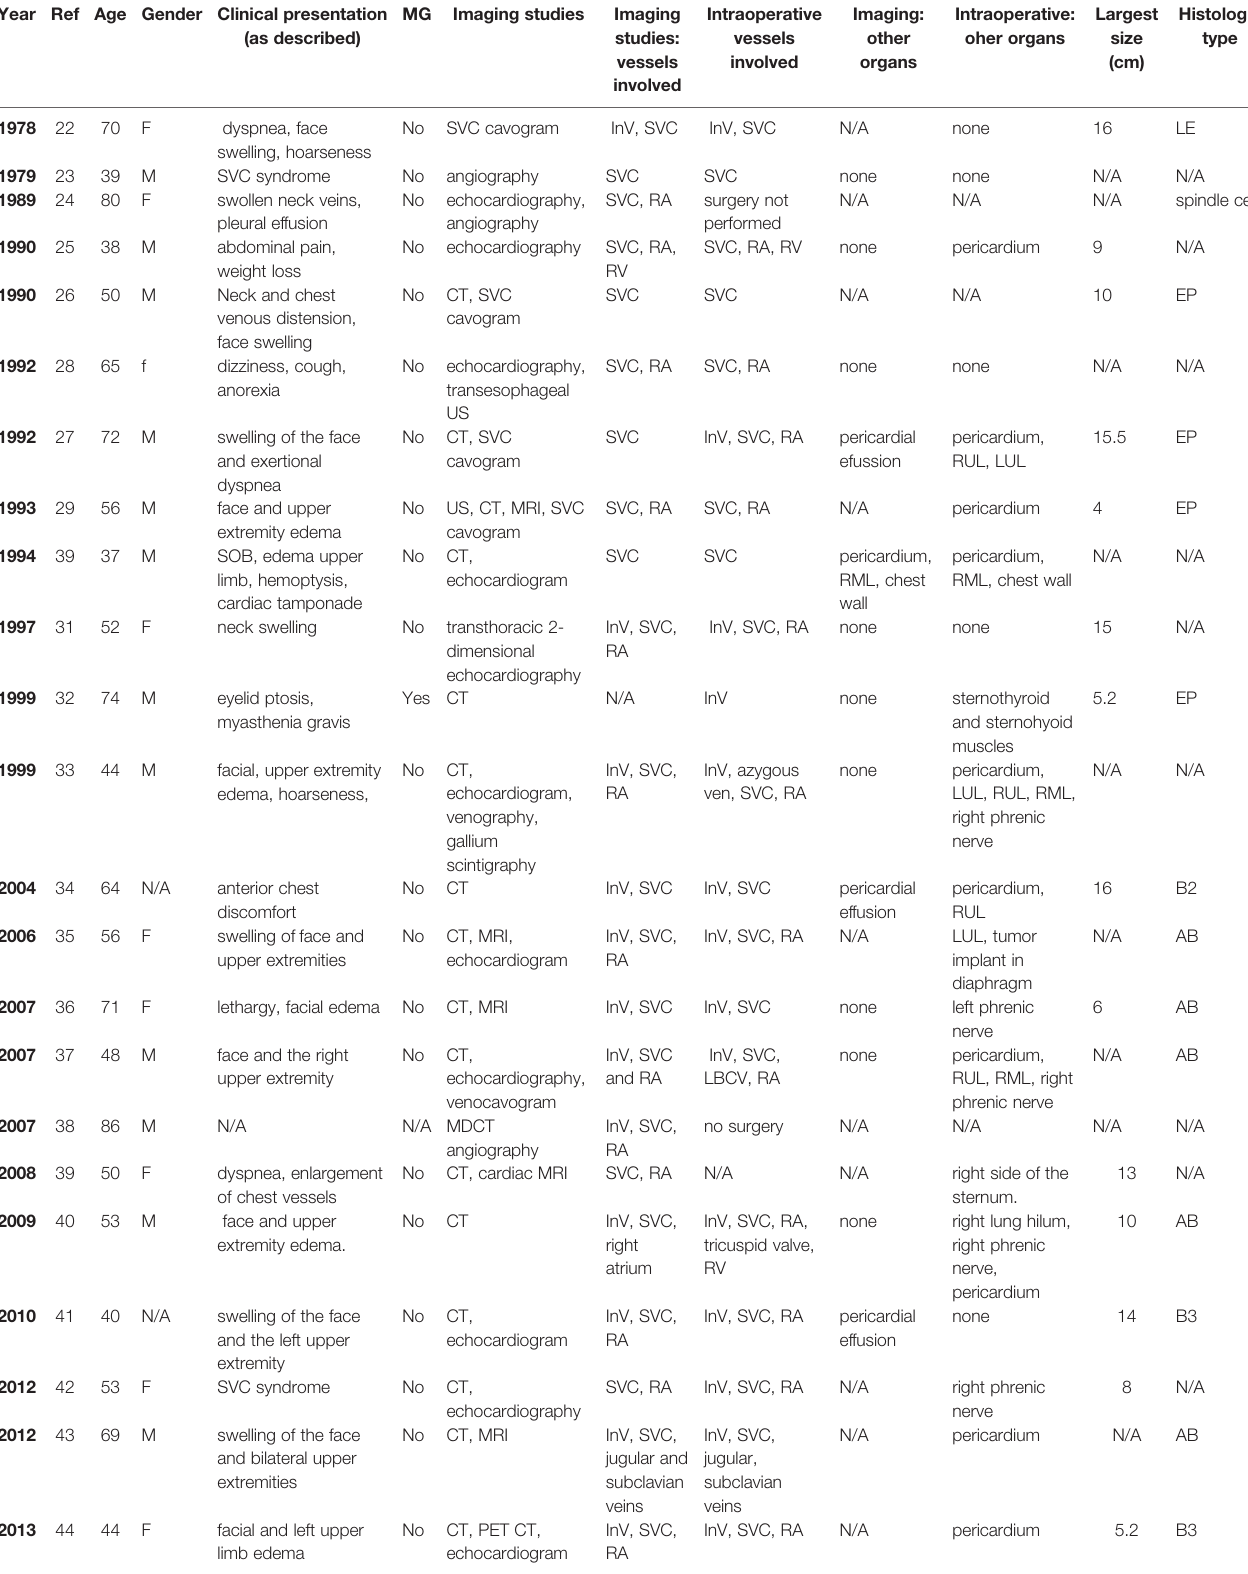
TABLE 3 | Patient characteristics and tumor details. Year Ref Age Gender Clinical presentation (as